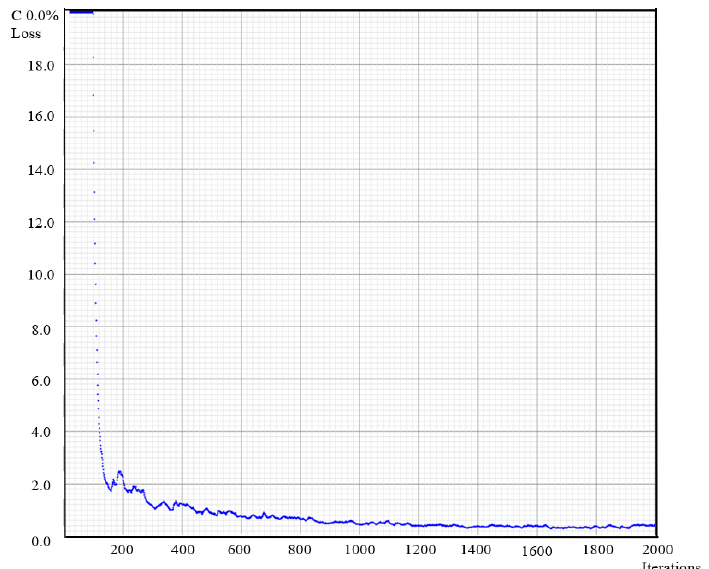
Figure 9. Loss function curve of model training.